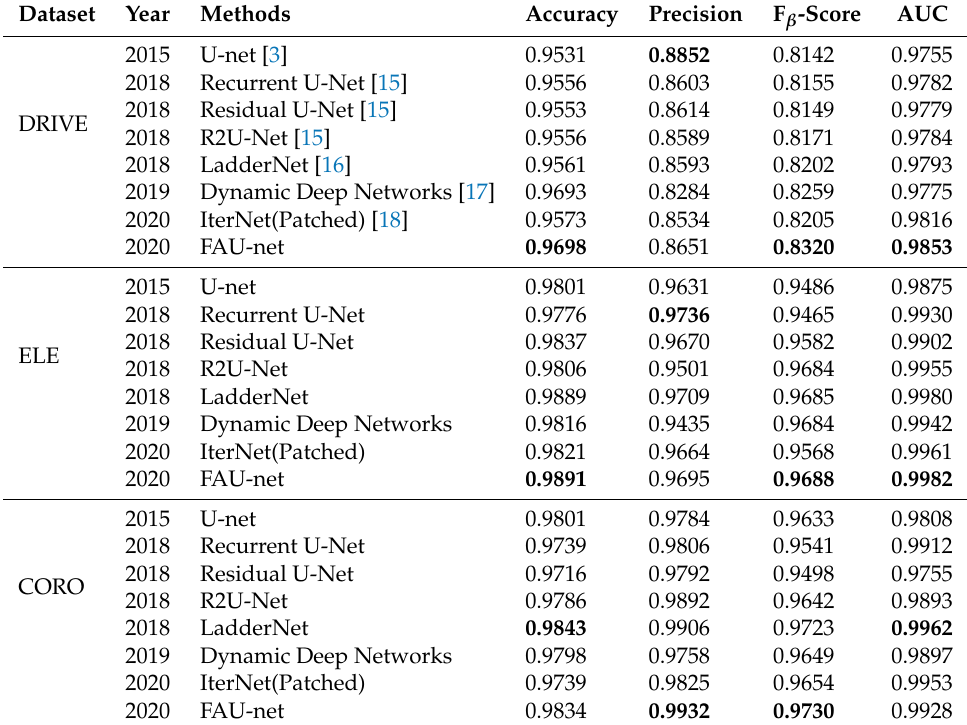
Table 4. Experimental results of FAU-net compared with other networks on DRIVE, ELE, CORO data sets.